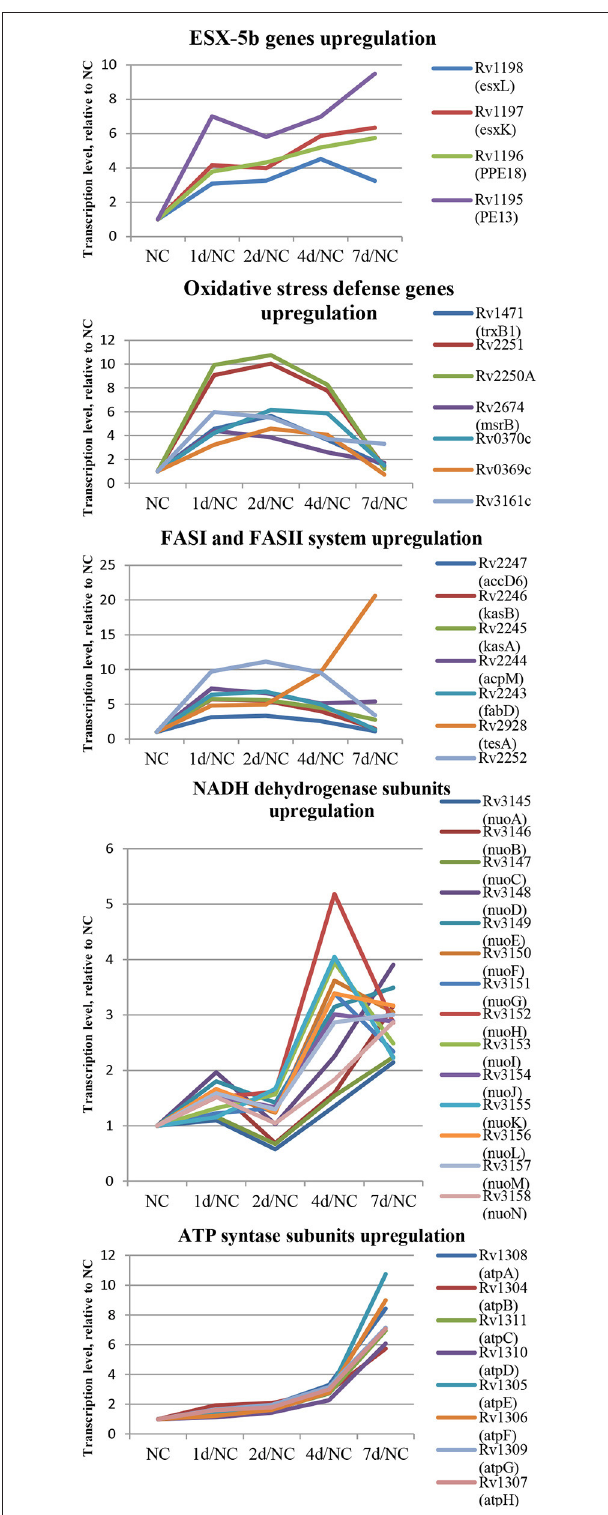
FIGURE 5 | Dynamics of several functional groups expression during resuscitation. Differential expression is given relative to dormant NC state.